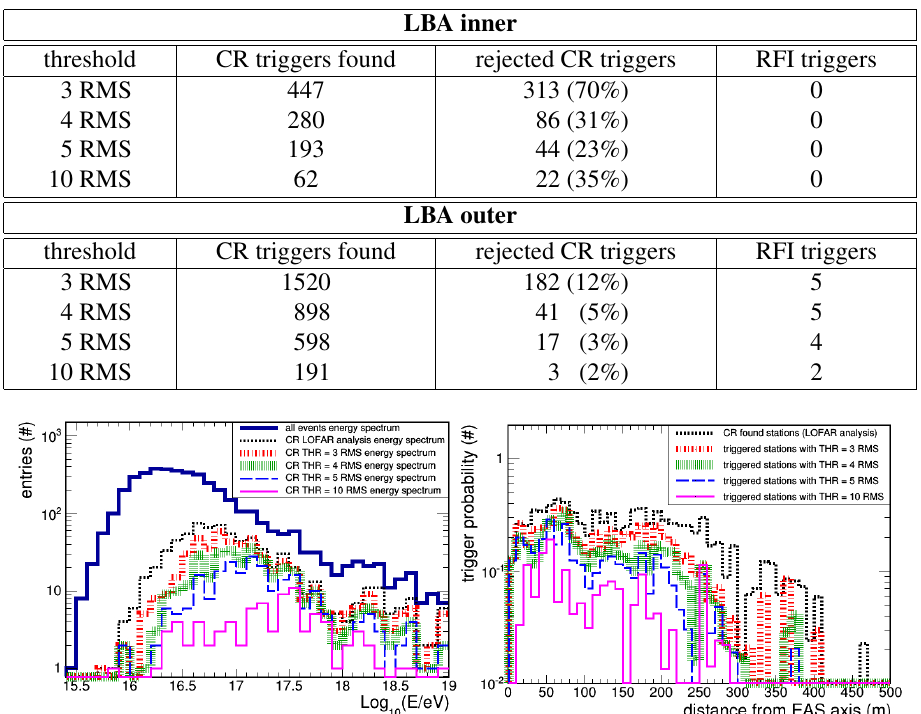
Figure 1. Left – Energy distribution of the LORA triggered dataset with “LBA outer” configuration: the whole set of showers (dark blue), the showers detected with the LOFAR o ff -line analysis (in black), and the showers detected with the self-trigger algorithm with threshold of 3 (red), 4 (green), 5 (blue), and 10 RMS (magenta). Right – Trigger probability for showers with energy above 2 10 eV 17 and “LBA outer” configuration vs. the × station distance from the shower axis for the LOFAR o ffl ine analysis (black) and the self-trigger algorithm with threshold 3 (red), 4 (green), 5 (blue), and 10 RMS